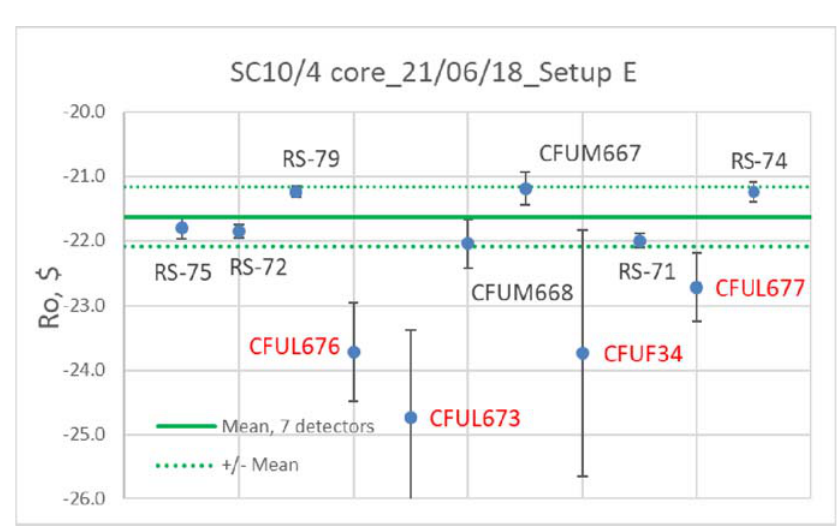
Figure 3. The SC10/4 core sub-criticality measured with detector Setup E. Table III. Reactivity values obtained with SJI method and MCNP calculations for